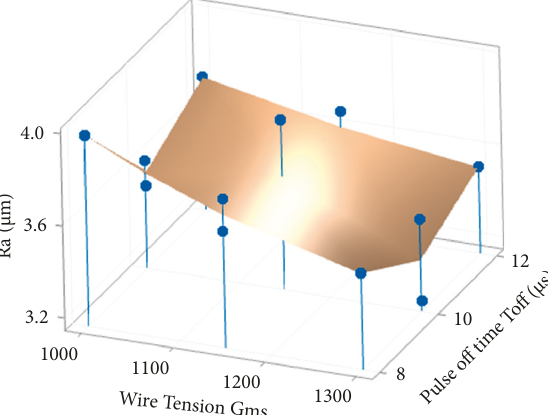
Figure 7: Three-dimensional response surface graphs-MRR. Figure 8: Three-dimensional response surface